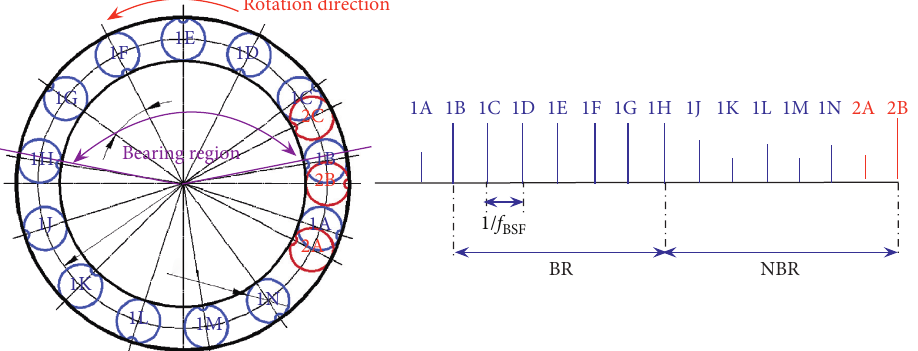
Figure 26: Dynamic action relationship between races and roller fault.